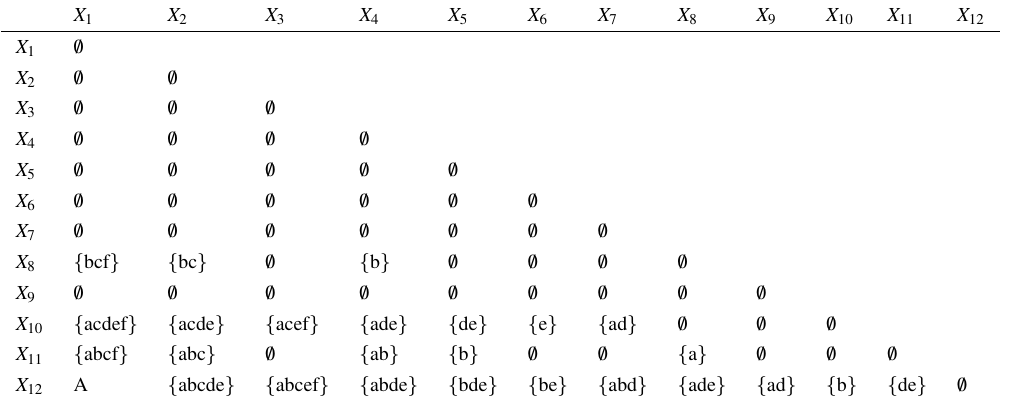
Table 2: Discernibility matrix of condition attributes